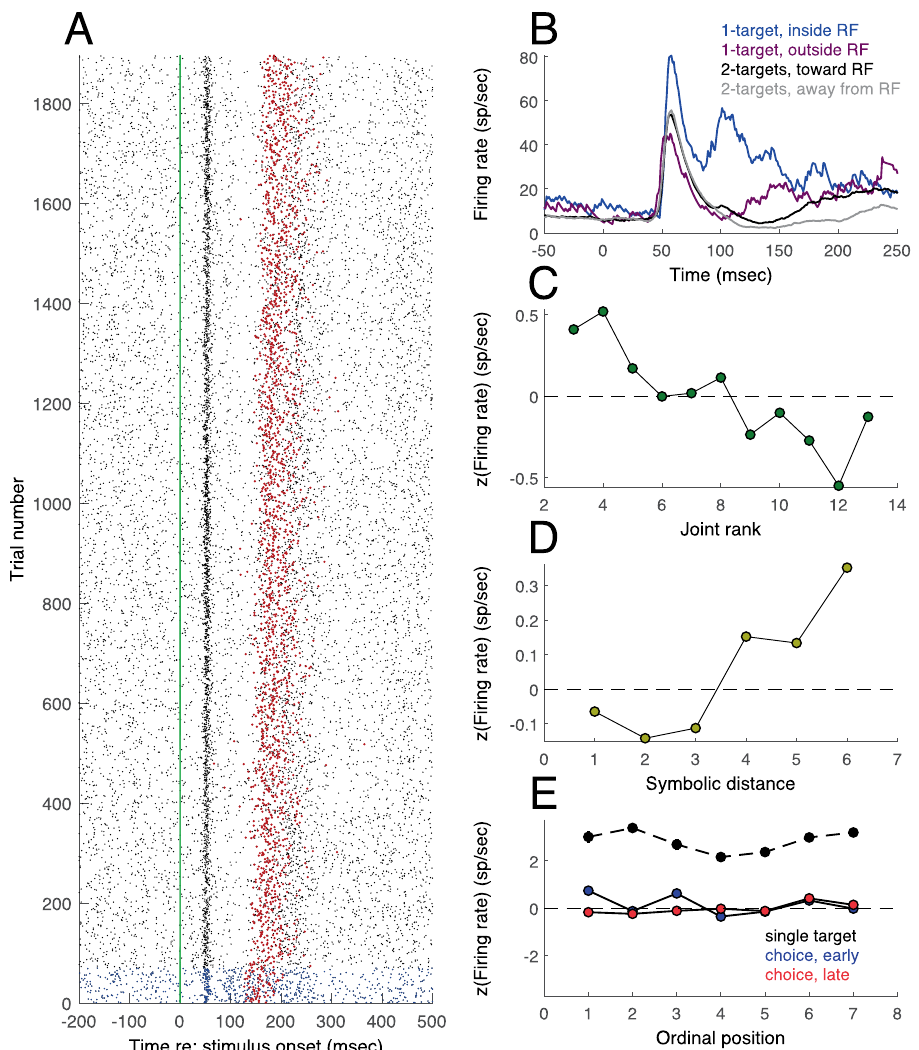
Figure 2. Example of a recording session for one cell. ( A ) Spike raster aligned on stimulus onset (vertical green line). Each blue dot (for single target trials) or black dot (for choice trials) represents an action potential. Each row is one trial. Red dots are saccade latencies. ( B ) Smoothed average firing rate vs. time. Blue line is for a single target in the receptive field, purple for a single target outside the receptive field. Black/gray corresponds to choice trials (two targets) where the saccade was toward (black) or away (gray) from the receptive field. ( C ) z - scored firing rate vs. joint rank for all choice (2-target) trials. ( D ) z -scored firing rate vs. symbolic distance for all choice trials. ( E ) z -scored firing rate vs. ordinal